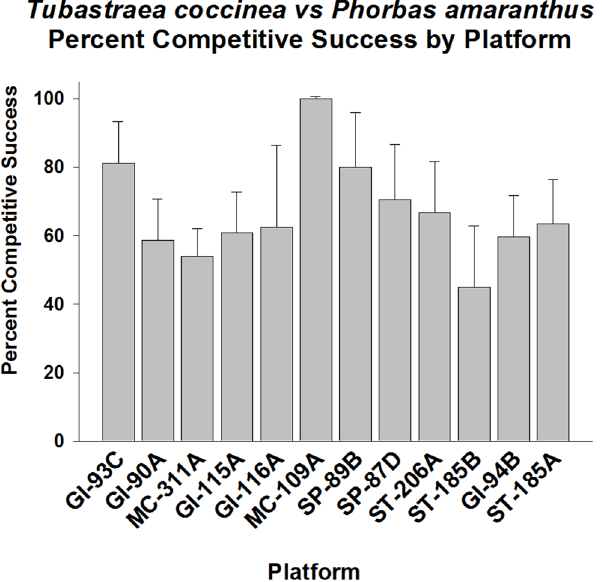
Fig 12. Percent of wins in competition for space between Tubastraea coccinea and Phorbas amaranthus , by platform. Mean plus 95% confidence limits shown. Range of number of interactions per platform (n): 17 – 150. See Fig 2 legend for additional details. Overall competitive success significantly higher than the 50% level (p < 0.01, Fisher ’ s Exact Test). Frequency of competitive success varied significantly between platforms. The following platforms exhibited significantly high competitive success frequencies: GI- 93C, GI-90A, GI-116A, MC-109A, and SP89B (p < 0.05 – 0.01, Goodness of Fit Test, G-statistic). The remainder (most of the platforms) exhibited competitive success frequencies not significantly different from 50% (p >